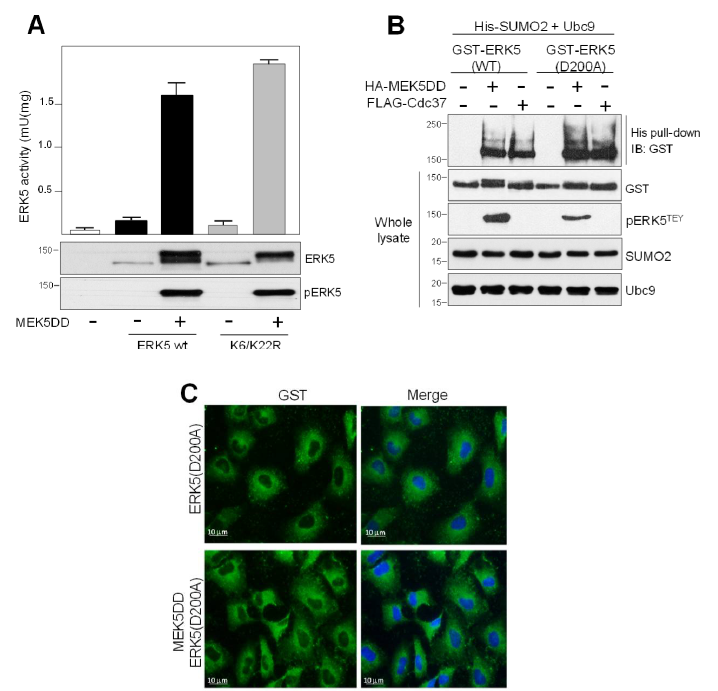
Figure 4. ERK5 SUMOylation is not necessary for ERK5 kinase activity. (A) HEK293T cells overexpressing GST-tagged ERK5 (wild type or SUMO-deficient K6/22R mutant), alone or in combination with MEK5DD, were lysed, and the GST-ERK5 protein was affinity-purified and assayed for kinase activity, as described in the Methods Section. Activity data are the mean ± SD of two independent experiments, each performed in triplicate. Cell lysates were also immunoblotted for ERK5 (anti-GST antibody) and for phosphorylated ERK5 (pERK5). (B) HEK293T cells were co-transfected with His-tagged SUMO2 and Ubc9, and the indicated combinations of GST-tagged ERK5-D200A (kinase inactive), HA-tagged MEK5DD (constitutively active) and FLAG-tagged Cdc37. After lysing the cells with denaturing buffer containing NEM, SUMOylated ERK5 was affinity-purified using Ni 2+ -agarose beads and detected by immunoblotting with anti-GST antibody. Levels of overexpressed proteins and phosphorylated ERK5 at the T-loop are shown using the corresponding antibodies. Similar results were obtained in three independent experiments. (C) Immunofluorescence microscopy. PC-3 cells were transfected with GST-tagged ERK5 (wild type or kinase-inactive mutant D200A) and MEK5DD plasmids. After 24 hours, cells were fixed with paraformaldehyde and immunofluorescent staining for ERK5 (green) using anti-GST antibody. Nuclei were stained with Hoechst